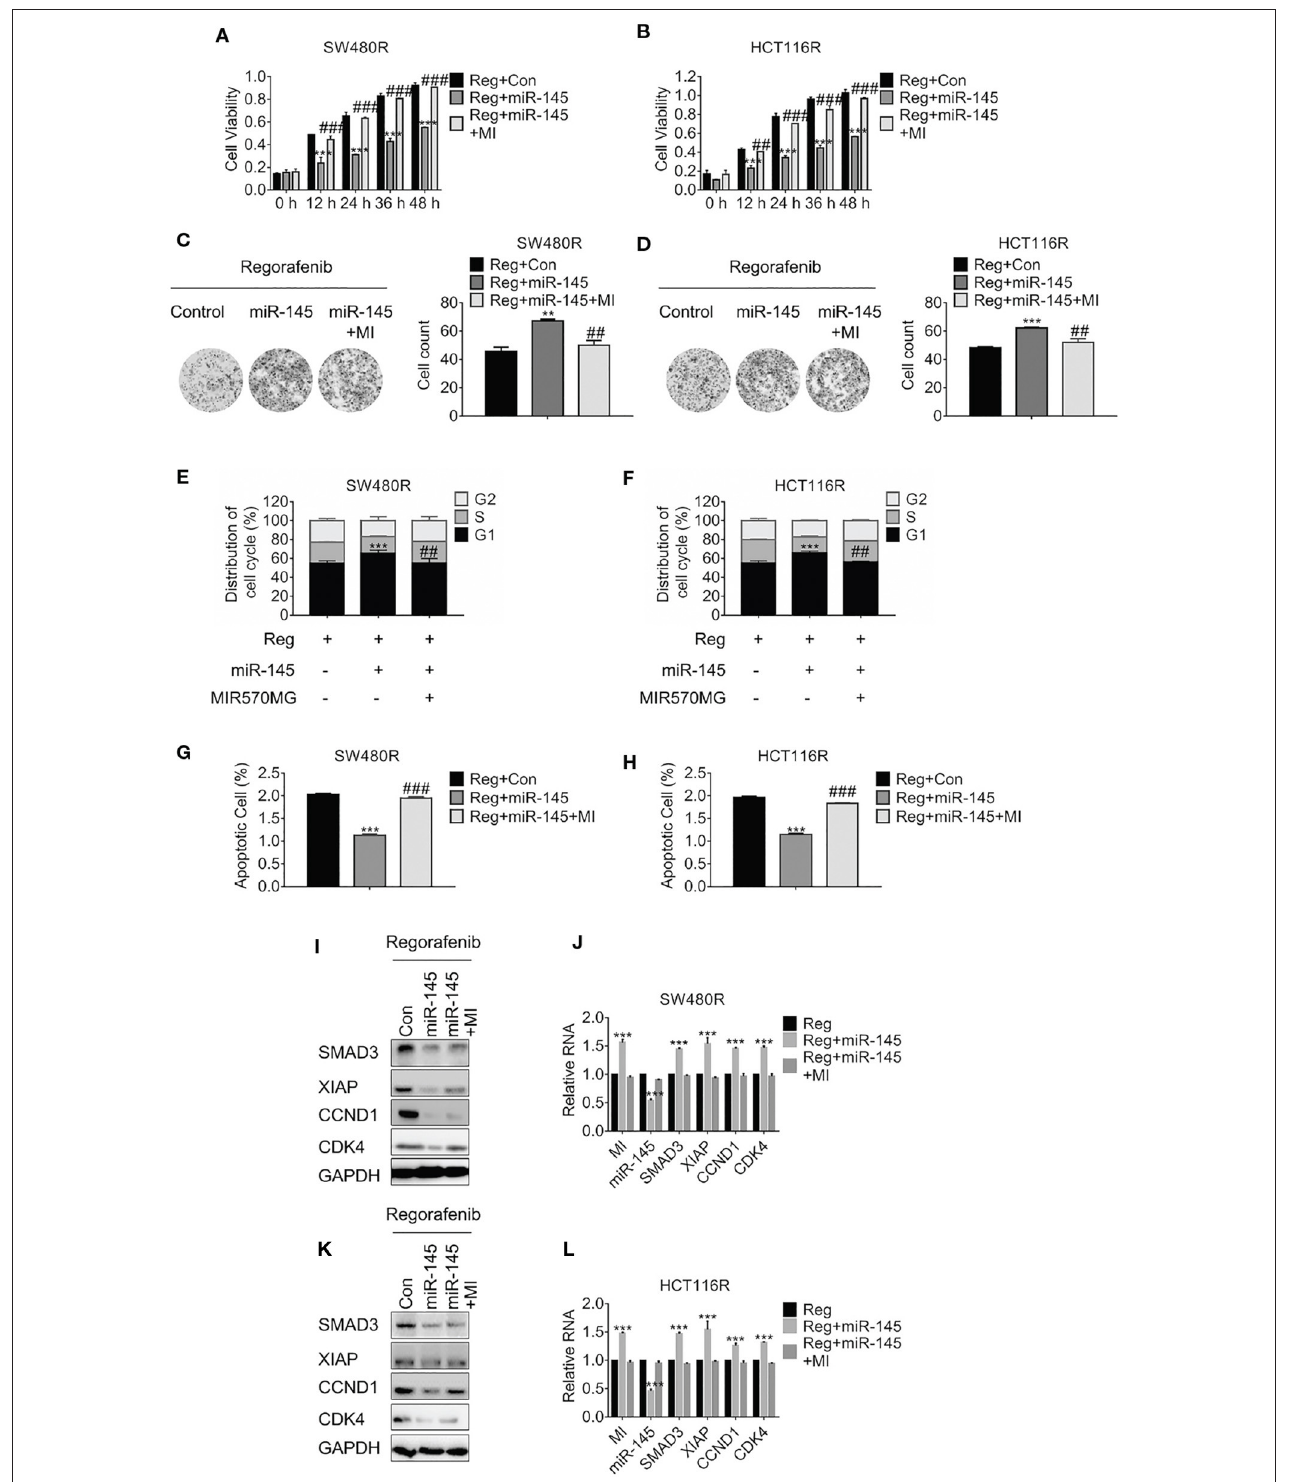
FIGURE 5 | MIR570MG confers resistance against regorafenib by releasing SMAD3 from miR-145. (A,B) Cell viability of SW480R and HCT116R was accessed by MTT assay. Cells expressing miR-145 or miR-145 plus MIR570MG were treated with Regorafenib. MTT assay was conducted post-treatment at different time-points. (C,D) Colony formation of SW480R and HCT116R was performed post-regorafenib treatment. Cells were transfected with MIR570MG or the combination prior to regorafenib treatment. (E,F) Distribution of cell cycle of the indicated cells were analyzed by flow cytometry. Cells expressing miR-145 or the combination were exposed to 1 µ M regorafenib for 24h prior to flow cytometry analysis. (G,H) Apoptosis of SW480R and HCT116R was measured post-regorafenib treatment. Cells